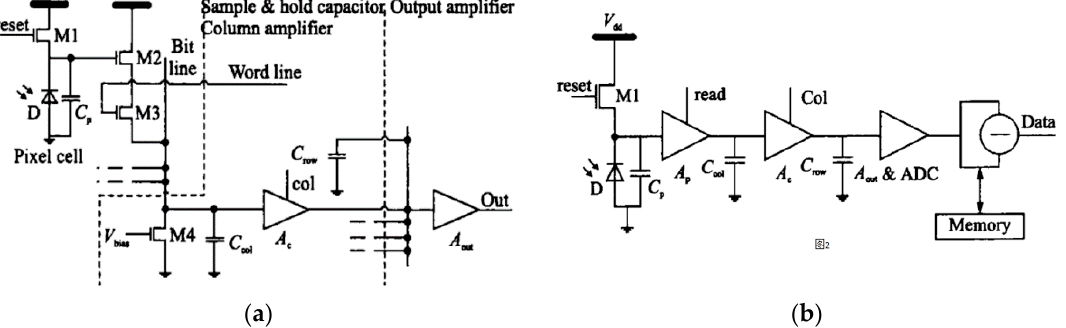
Figure 1. A 3T circuit structure of CMOS Image Sensor (CIS) single pixel. ( a ) A 3T active pixel structure. ( b ) A 3T structure equivalent circuit.